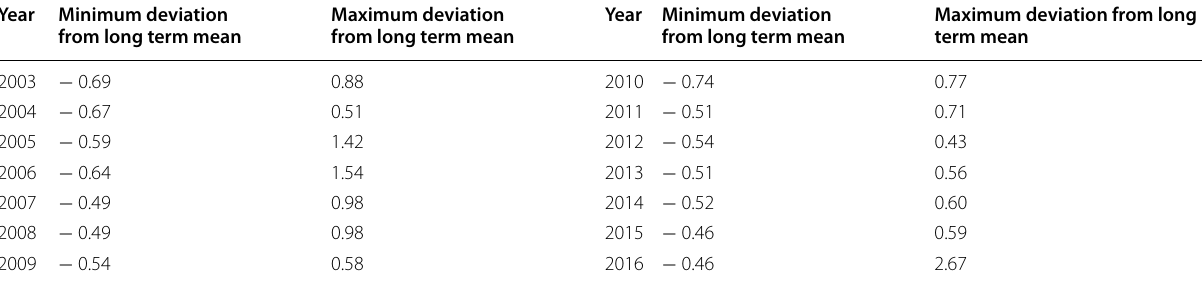
Table 5 Vegetation disturbance Year Minimum deviation from long term mean